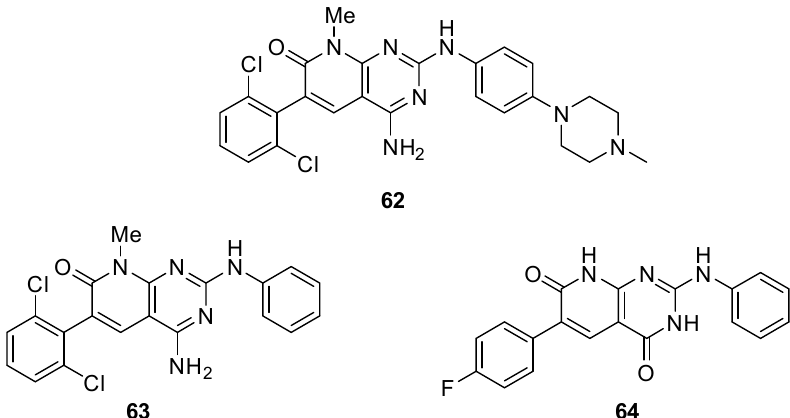
Figure 20. Pyrido[2,3- d ]pyrimidin-7(8 H )-ones with nM biological activities as BCR kinase inhibitor ( 62 ), DDR2 inhibitor ( 63 ), and HCV NS5B polymerase inhibitor ( 64 ).